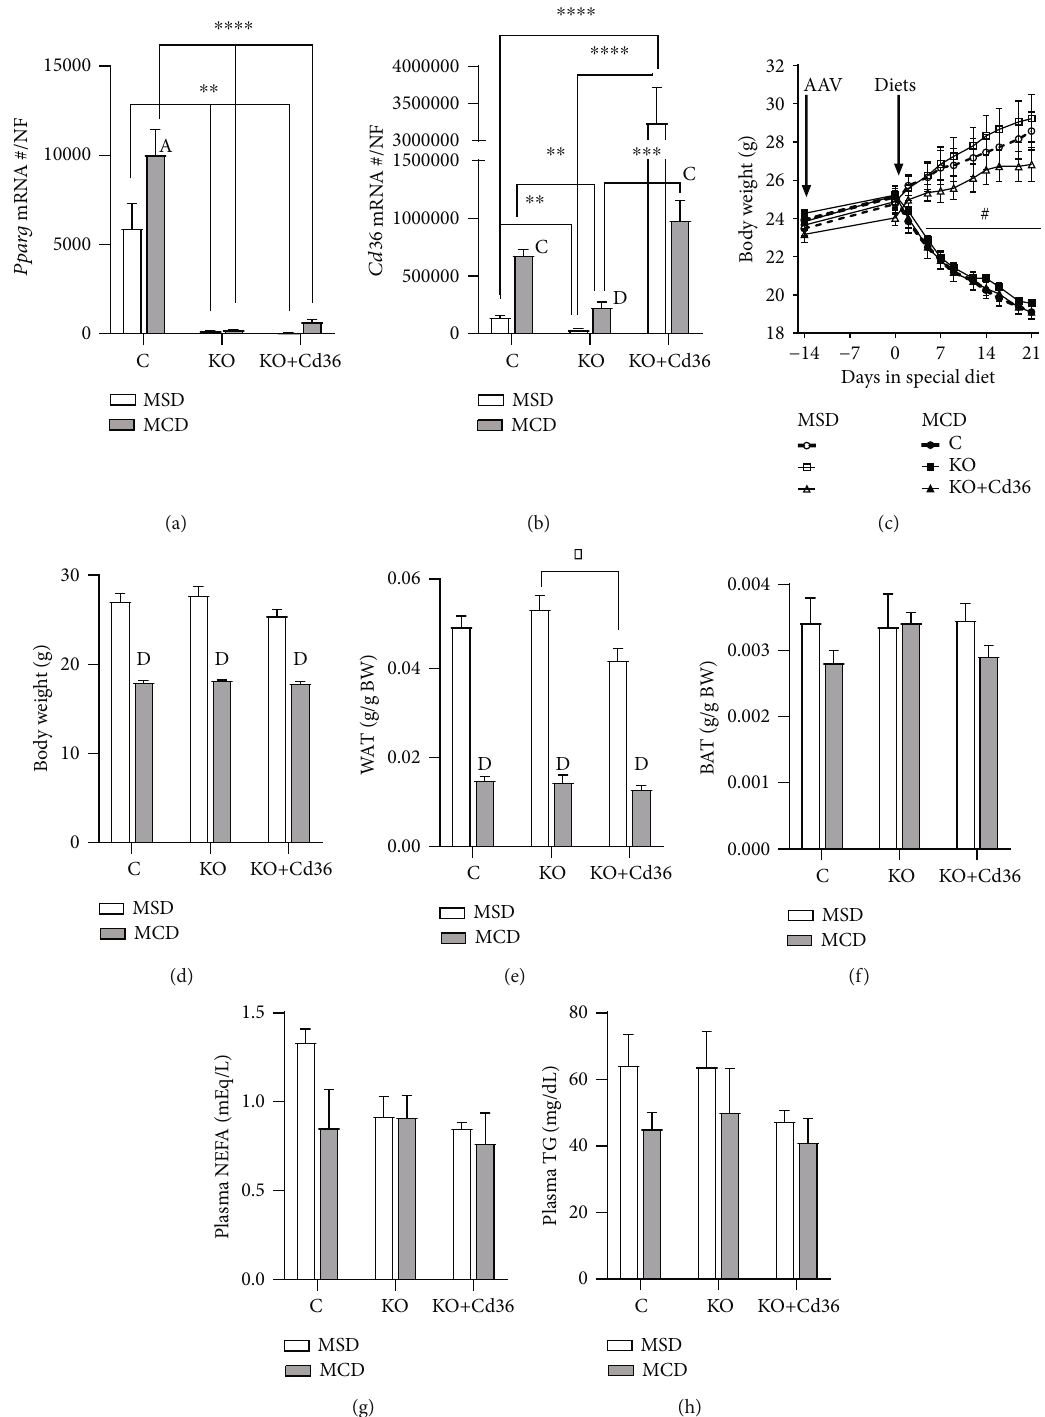
Figure 1: E ff ect of MCD diet on body composition, plasma lipids, and ALT levels of Pparg Δ Hep mice and Pparg Δ Hep mice with overexpression of hepatocyte CD36. Hepatic expression of (a) Pparg and (b) Cd36 . Gene expression is represented as an absolute copy number normalized by the normalization factor (NF). (c) Changes in body weight induced by MSD and MCD diets. (d) Body weight at sac. (e) Relative white adipose tissue (WAT) weight. The weight of WAT is the sum of urogenital and subcutaneous adipose tissue weights. (f) Relative brown adipose tissue (BAT) weight. Plasma (g) NEFA and (h) TG levels. Values are represented as the mean ± standard errorof the mean . Letters or # represents signi fi cant di ff erences between MSD and MCD within the group. Asterisks indicate signi fi cant di ff erences between groups within the same diet. ∗ , A , # p < 0 : 05 ; ∗∗ , B p < 0 : 01 ; ∗∗∗ , C p < 0 : 001 ; ∗∗∗∗ , D p < 0 : 0001 . Control mice (C, circles); Pparg Δ Hep mice (KO, squares); Pparg Δ Hep mice with hepatocyte CD36 overexpression (KO+Cd36, triangles). MSD diet: open columns, open symbols; MCD diet: close columns, close symbols. n = 3 ‐ 7